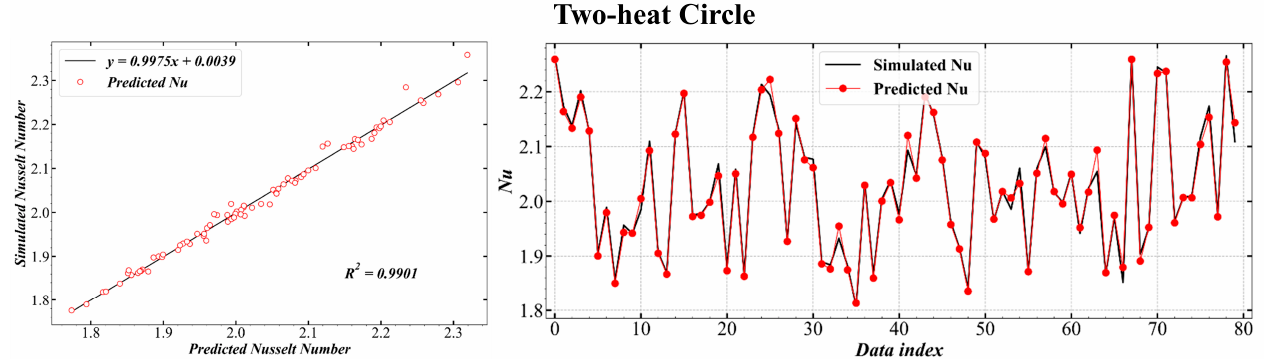
Figure 8. Comparison of predicted and simulated average Nusselt number with various inner cylinder positions on 80 test